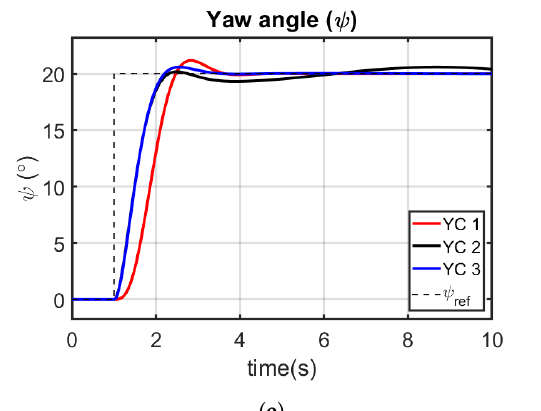
Figure 6. Time response of the lateral states: ( a ) sideslip ( β ) . ( b ) roll angle ( φ ) . ( c ) roll rate ( p ) .